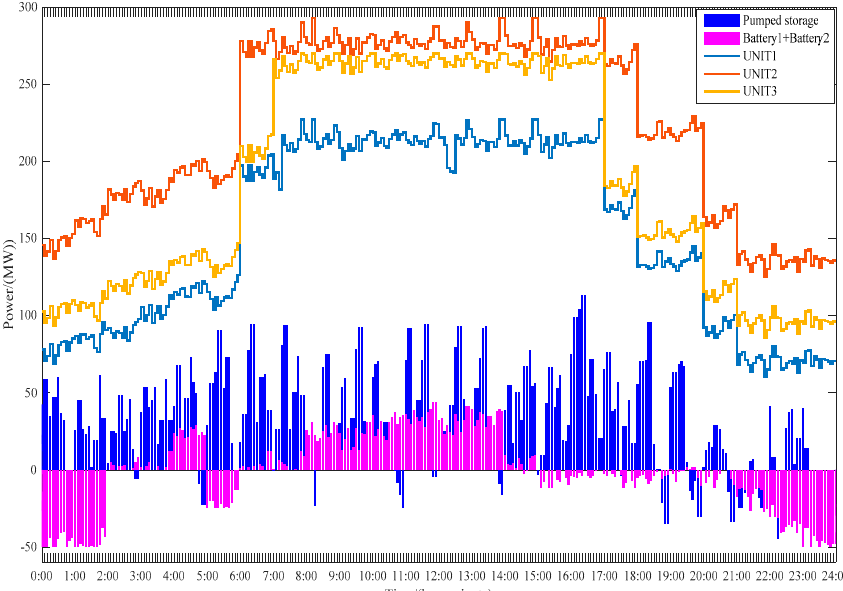
Figure 6. Active power output of thermal power unit, hydro-pumped storage unit, and batteries after applying the real-time corrective schedule.